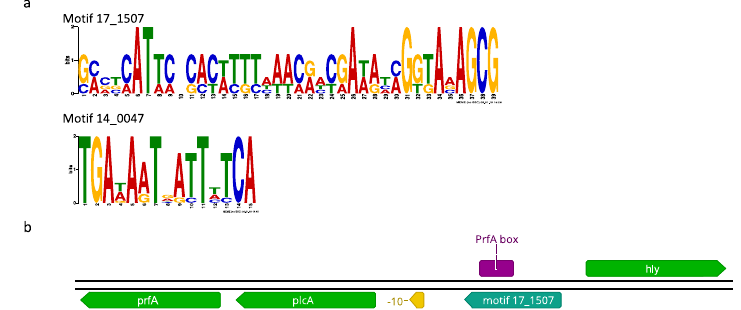
Figure 3. Motif search within 150 bp upstream of differentially expressed genes. ( a ) Sequence logos for motifs 17_1507 and 14_0047 ( b ) Schematic representation of the genomic context of motif 17_1507 in the promoter upstream of plcA. Coding sequences are not drawn to scale.